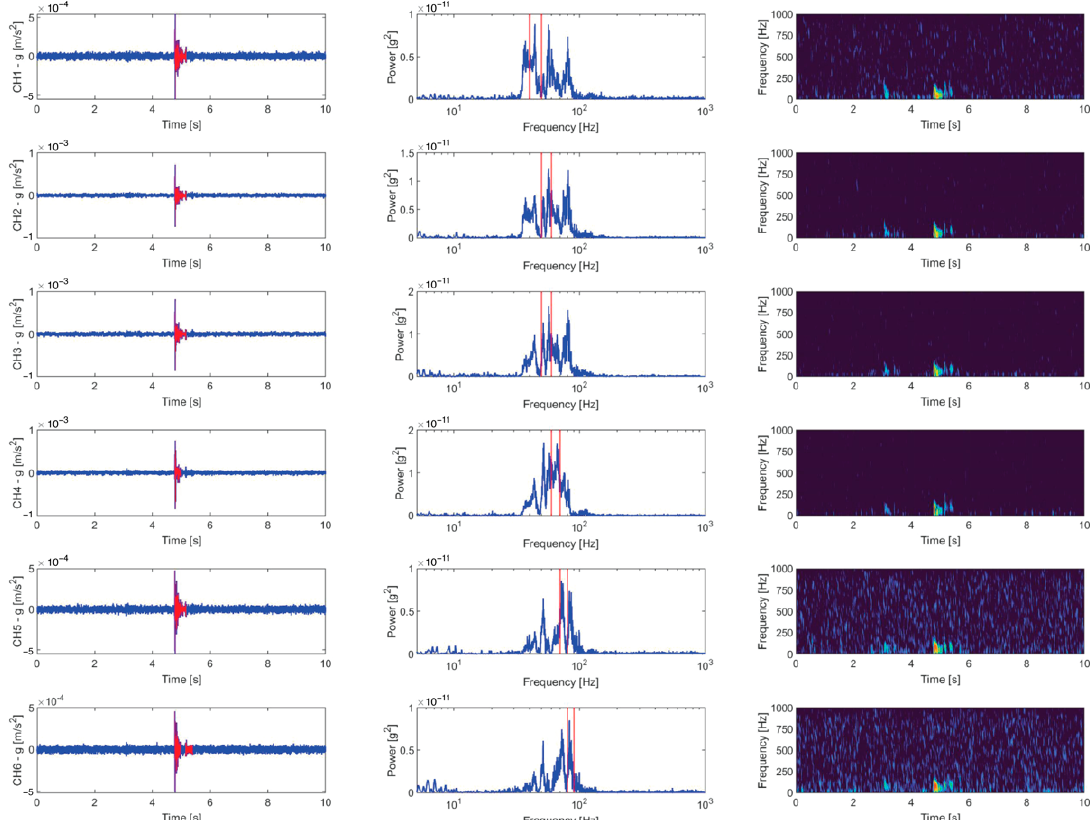
Figure 4. Example of one event automatically detected and classified as an MS event through visual screening of its time- and frequency-domain features (left: signal waveform; center: power spectral density estimate; right: spectrogram).